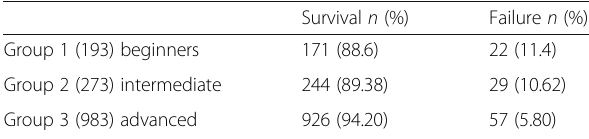
Table 3 Distribution of Implant outcomes amongst clinicians through various level of training